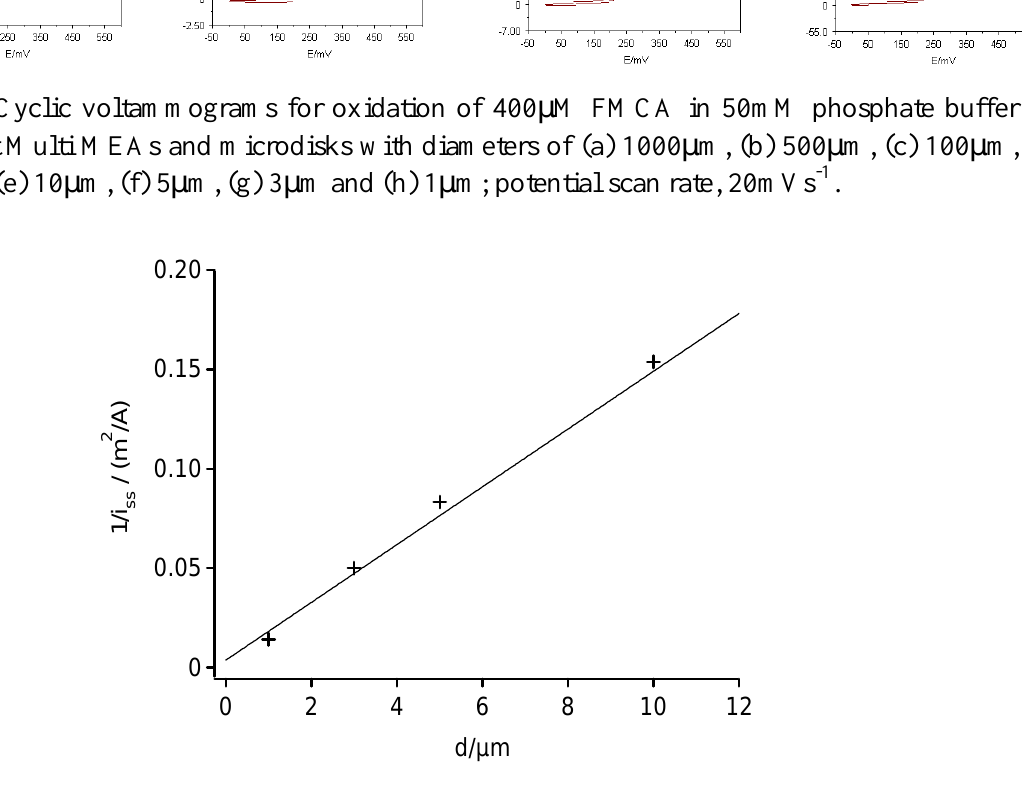
, versus the microdisk diameter, ss